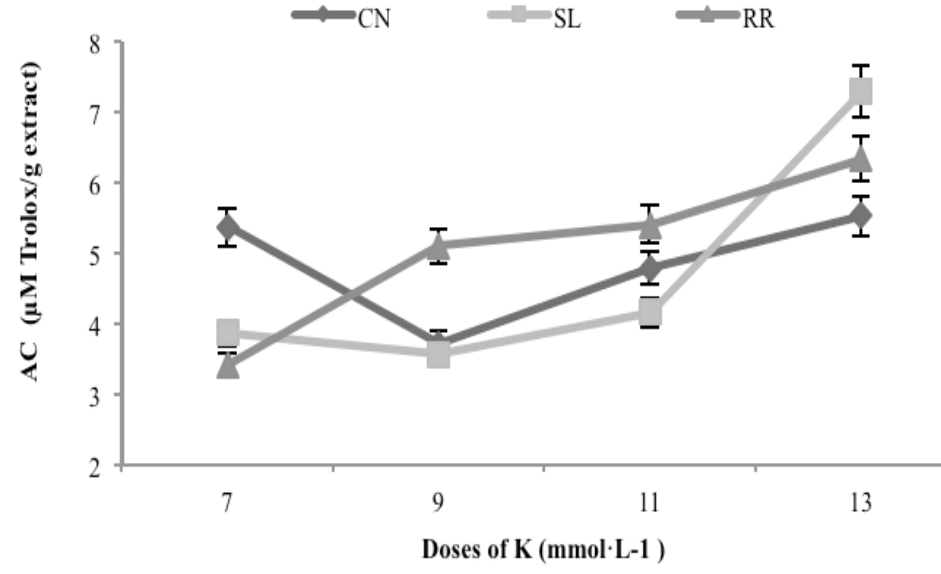
Figure 4. Effects caused by interaction of Genotype and doses of K + (G × DK) for Antioxidant Capacity (AC) of hydroponic basil. CN: “Cinnamon”; SL: “Sweet Lemon”; RR: “Red Rubin”. Interval bars are the standard error.